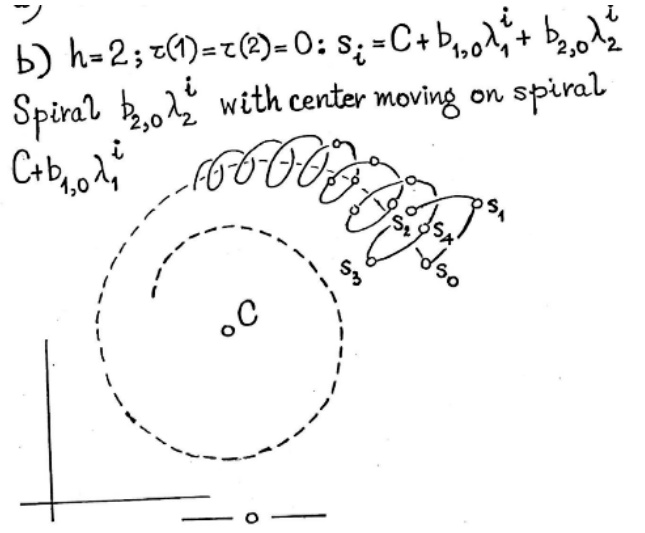
Figure 3. Second order spiral of form (b) drawn by